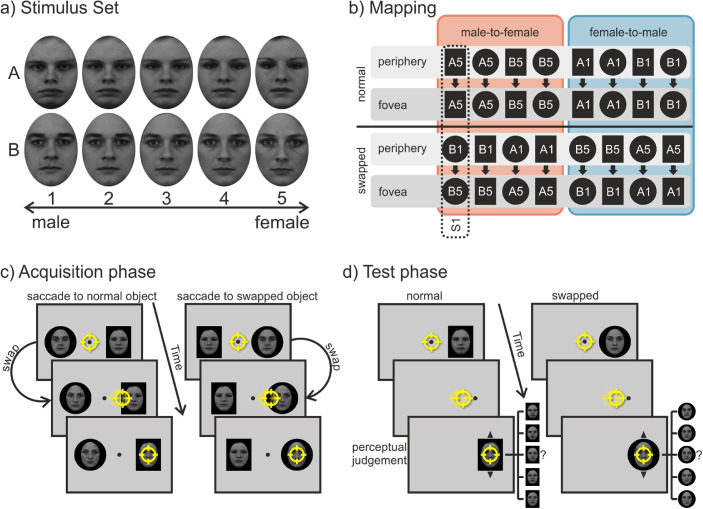
Design of Experiment 2. (a) Entire stimulus set containing two face sequences (A and B) ranging from male to female. The numbers indicate the gender score. (b) Schematic mapping of all the different counterbalanced stimulus combinations used in the acquisition phase. The black circles and rectangles picture the fixed background shape behind the face image, and the letters and numbers represent the specific face. For each subject (each vertical column, one example is indicated by the dashed line), there was a fixed mapping between the peripheral (i.e., presaccadic) and foveal (i.e., postsaccadic) view of the faces. There was one face with the “normal” status that stayed the same and one face with the “swapped” status that changed either from male-to-female (outlined by the red box) or from female-to-male (outlined by the blue box) during the saccade. (c) Structure of a trial in the acquisition phase: Participants could saccade freely to either of two objects. During the saccade, one of the faces was swapped out for a face of the opposite gender. (d) Structure of a trial in the test phase: Participants had to saccade to the peripheral target, which was replaced by the fixation point as soon as the eye movement started. After the saccade, participants could go through the faces one at a time via mouse wheel and had to choose which of them they had perceived presaccadically. Note for (c) and (d), stimuli are not drawn to scale. The yellow circle represents the gaze position.